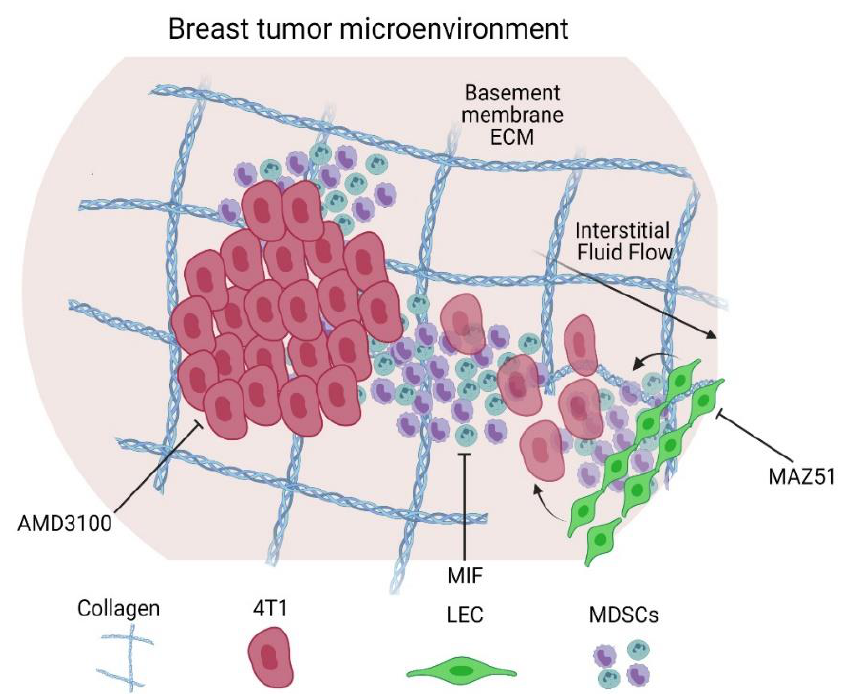
Figure 6. Schematic of invasion of LEC-4T1-MDSC crosstalk in the basement membrane extracellular matrix and inhibition under interstitial fluid flow. A straight arrow indicates interstitial fluid flow. Curved arrows indicate activation or interaction. Lines with stops indicate inhibition. (Created with BioRender.com. Accessed November 2021.)